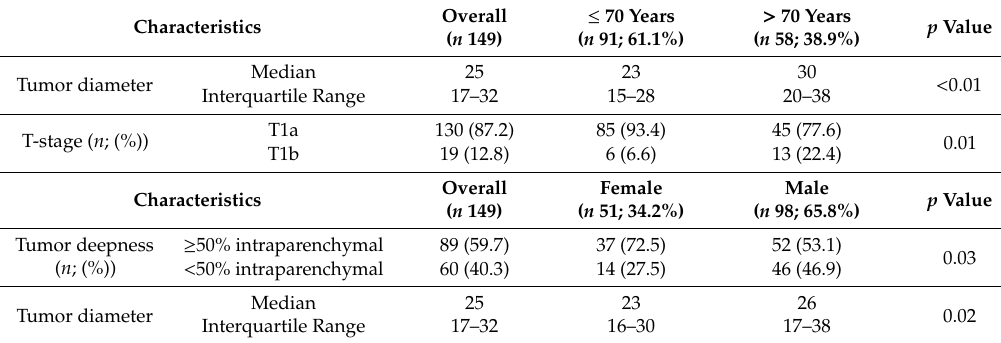
Table 2. Descriptive characteristics of 149 patients with non-metastatic T1a-b renal tumor treated with RFA from 2004 to 2015, stratified according to age group (younger or equal to 70 years vs. older than 70 years), gender (female vs. male), and BMI (normal vs. overweight / obese). Covariates consisted of: age, gender, BMI, tumor diameter, tumor stage, histovariant, tumor location, tumor laterality, tumor deepness, and PADUA